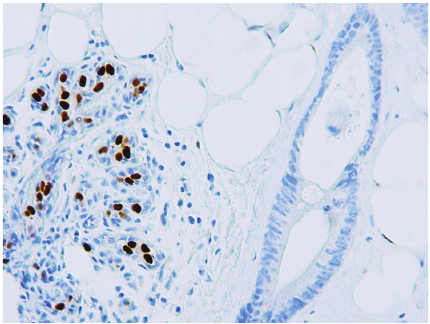
Figure9:Inbothofthesecases,benignbreastductalcellsareimmu- noreactive to estrogen receptor (left) and nonreactive to metastatic colonic glands (right) (200x